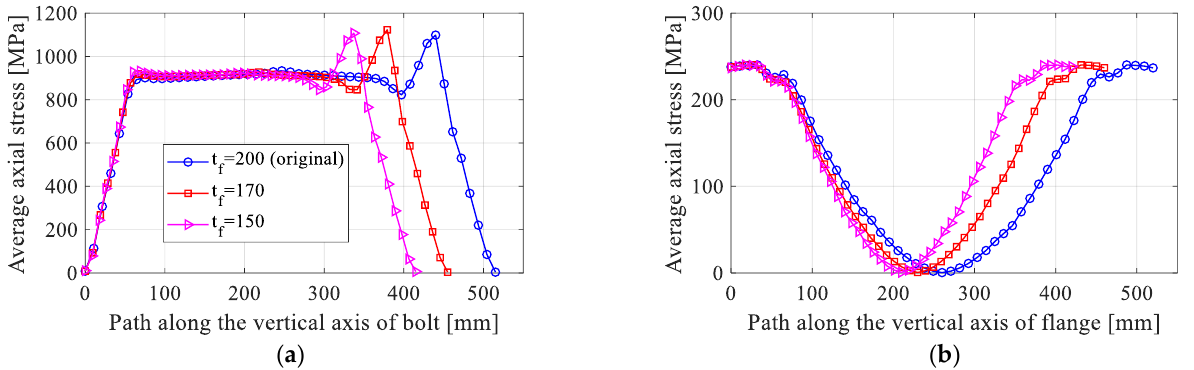
Figure 8. Influence of flange thickness on stress distributions: ( a ) bolt and ( b ) flange.